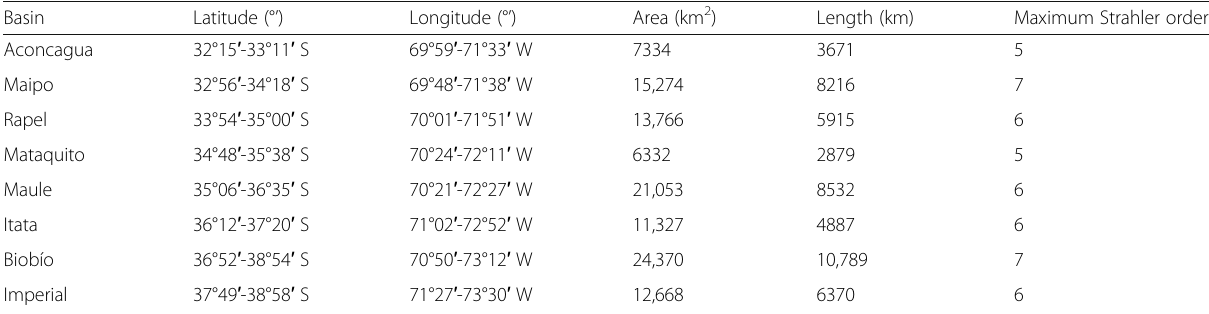
Table 1 Geographical and physical features of eight studied river networks. Latitude indicates the northern and southern boundaries, whereas Longitude indicates eastern and western boundaries of each river